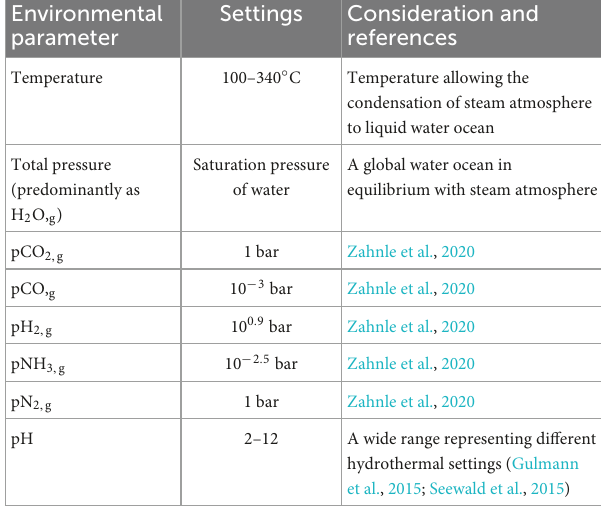
TABLE 1 Model settings for the impact